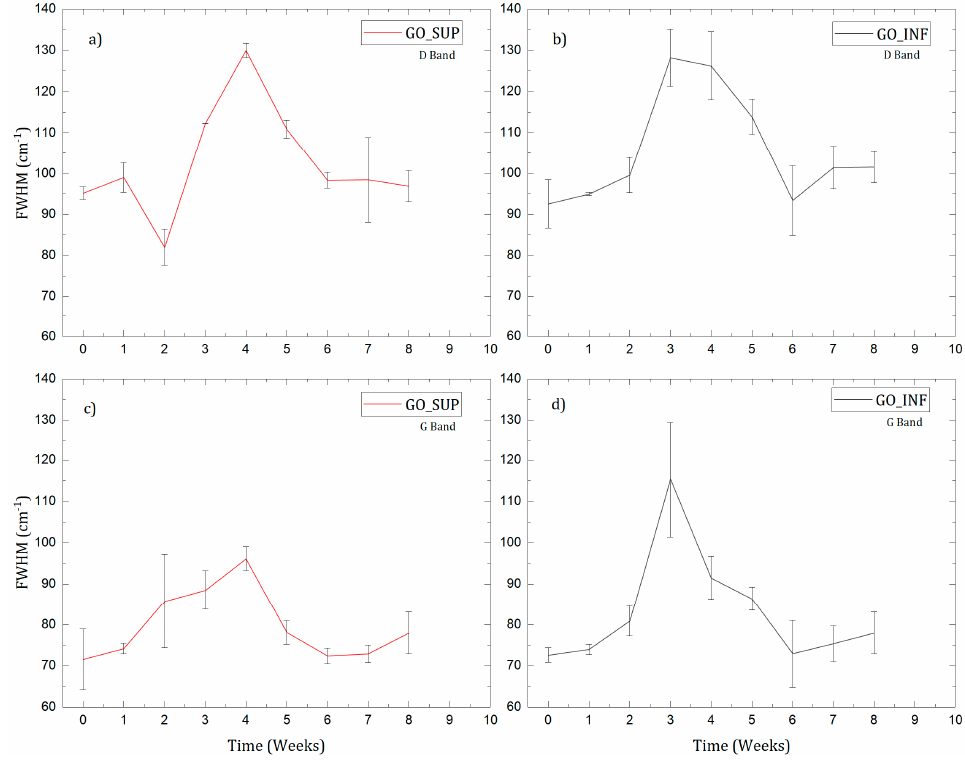
Figure 6. The FWHM values obtained after processing the D ( a , b ) and G bands ( c , d ) from the Raman spectra of dried GO_SUP and GO_INF samples.